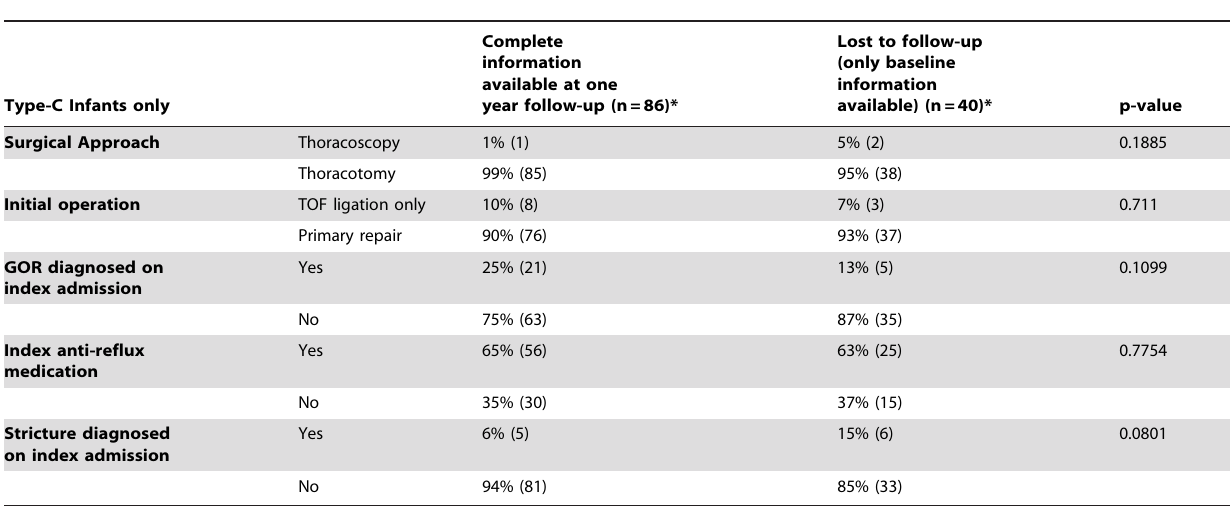
Table 2. Key characteristics of infants with complete follow-up information and those who have been lost to follow-up – type-c infants